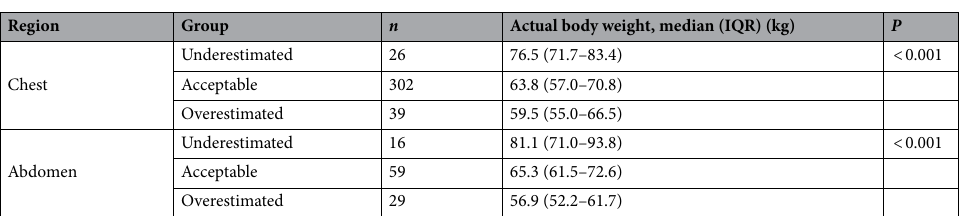
Table 2. Comparisons of actual body weights between underestimated, acceptable, and overestimated cases. IQR , interquartile range. The underestimated group was defined as the subjects with > − 5 kg from their actual body weight. The acceptable group was defined as the subjects within ± 5 kg from their actual body weight. The overestimated group was defined as the subjects > 5 kg from their actual body weight. The p -values were calculated by performing the Kruskal–Wallis test.